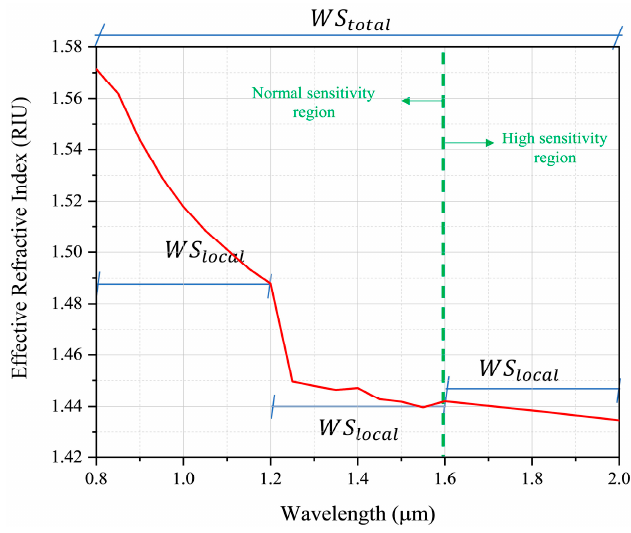
Figure 10. Sensor sensitivity regions scheme for doping with GeO (cid:2870) (19.3%) and n (cid:2911) = 1.41 .